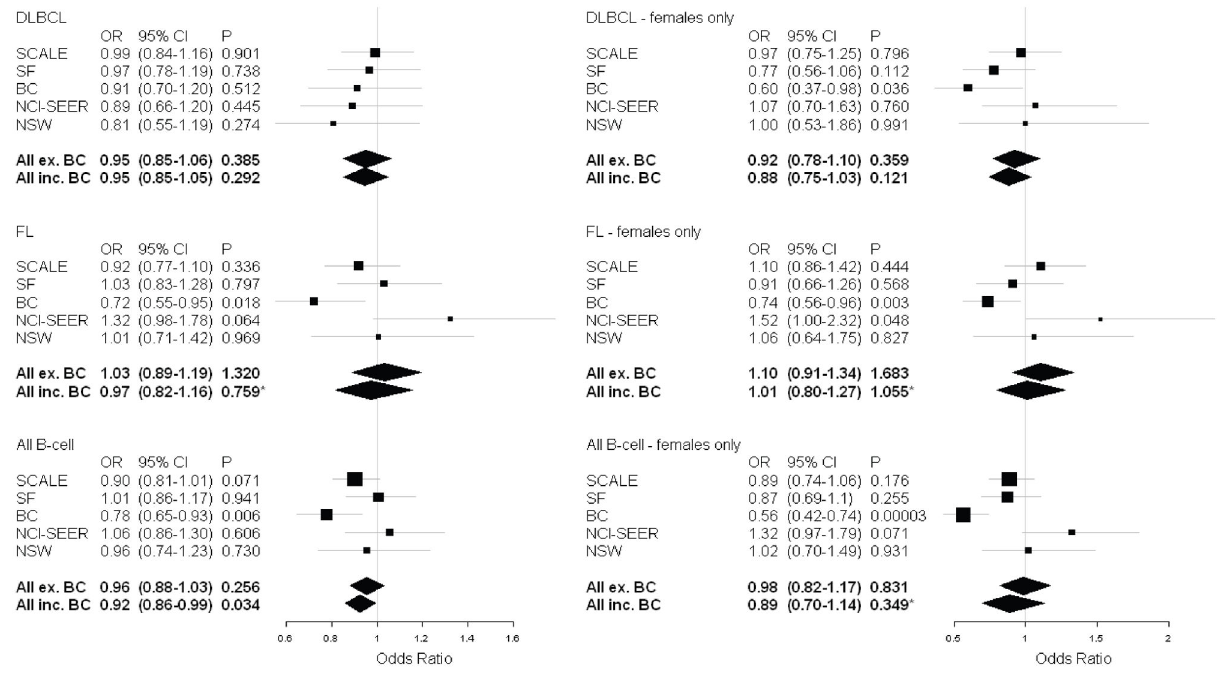
Figure 2. Forest plots for association of rs2509049 with DLBCL, FL and all B-cell lymphomas. Squares indicate the ORs, with the sizes proportional to the weight of the study in the meta-analysis. Summary ORs with and without the inclusion of the BC population are indicated in bold and designated with a diamond extending the width of the CI. All p values are from a fixed effects model except those indicated with an asterisk (*) which are from a random effects model. Q values for analyses including the BC dataset for DLBCL, FL and All B cell groups are Q =0.876, Q =0.053 and Q =0.161 for combined sexes, and Q =0.344, Q =0.045 and Q =0.002 for females only, respectively. Abbreviations: OR, odds ratio; 95% CI, 95% confidence interval; DLBCL, diffuse large B-cell lymphoma; FL, follicular lymphoma; all B-cell, all B-cell lymphomas; SCALE, Scandinavian Lymphoma Etiology; SF, San Francisco; BC, British Columbia; NCI-SEER, National Cancer Institute - Surveillance, Epidemiology and End Results; NSW, New South Wales. Figure created with rmeta version